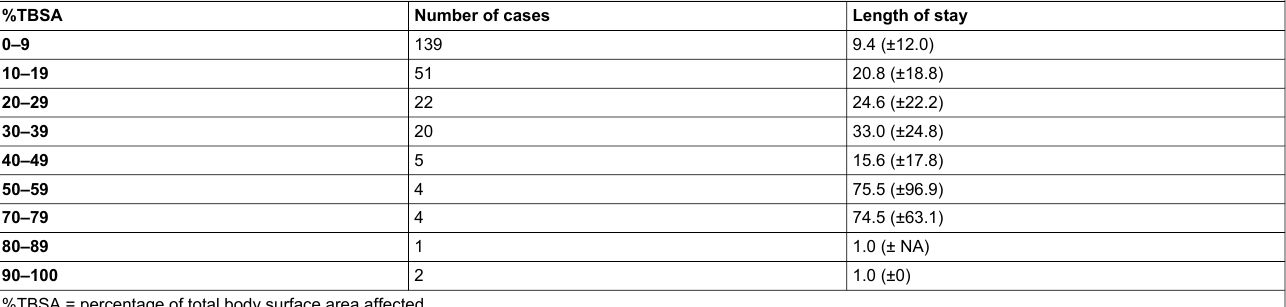
Table S6: Length of stay and category of %TBSA affected by burns. All burns discharges from the University Hospital of Zurich with an available %TBSA category (n =